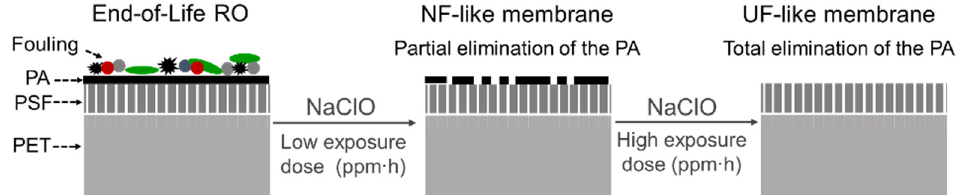
Figure 7. Schematic illustration of EoL RO membrane direct recycling by transformation to NF and UF-like membranes. PA, polyamide; PSF, polysulfone; PET, polyester. Adapted with permission from Ref. [86]. Copyright 2018, R. García-Pacheco et al. Table 1. Main characteristics of RO, NF, and UF membranes. Adapted from [4,118]. Reverse Osmosis